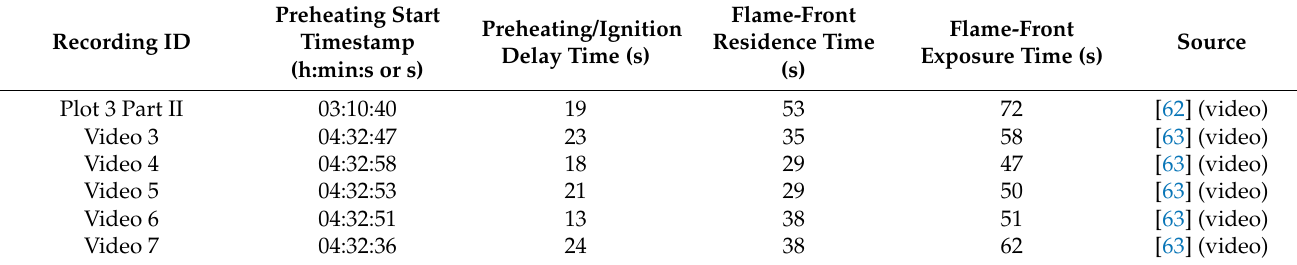
Table 1. Flame-front exposure time documented for high-intensity wildland crown fire-fronts during International Crown Fire Modeling Experiment in the Northwest Territories,